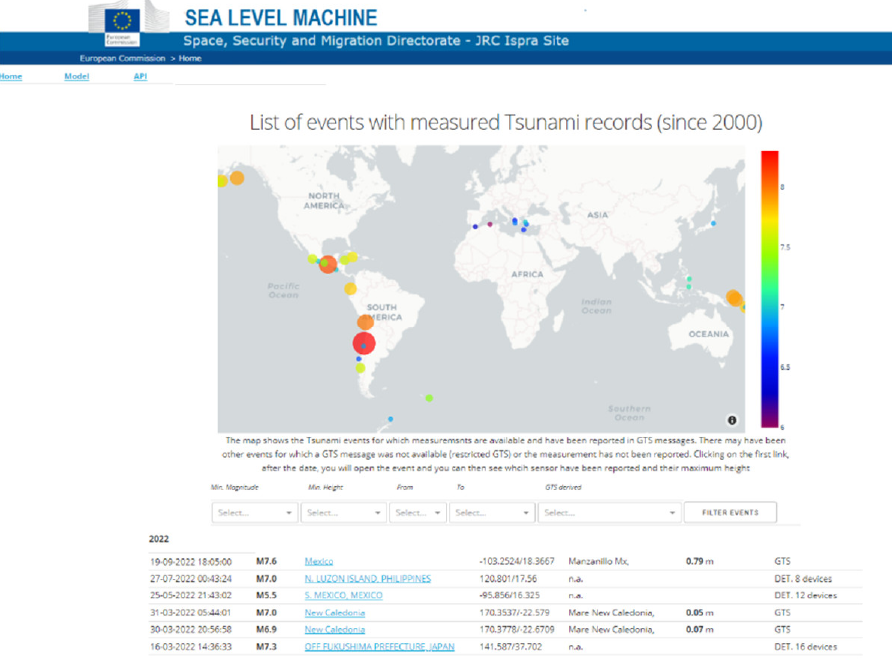
Figure A1. Screenshot of the SLM web site with the list of Tsunami events.